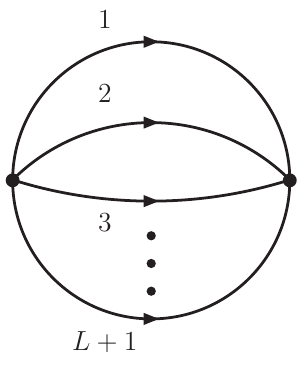
Figure 3 . The general form of the MLT ( L )